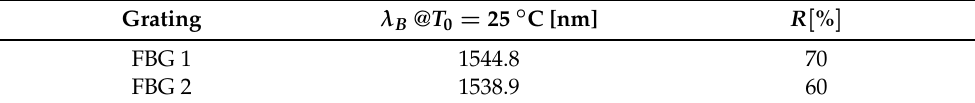
Table 1. Parameters of